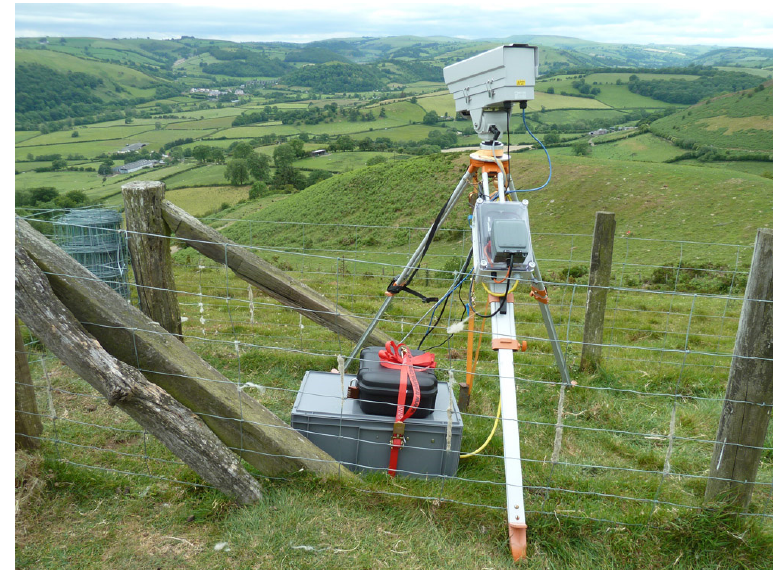
Figure 1. Showing deployment of the mobile IR camera system at Skyborry during the Local And Non local Fog EXperiment (LANFEX). The area covered by the IR images shown in Section 3.1 lie to the left of the camera in this image.